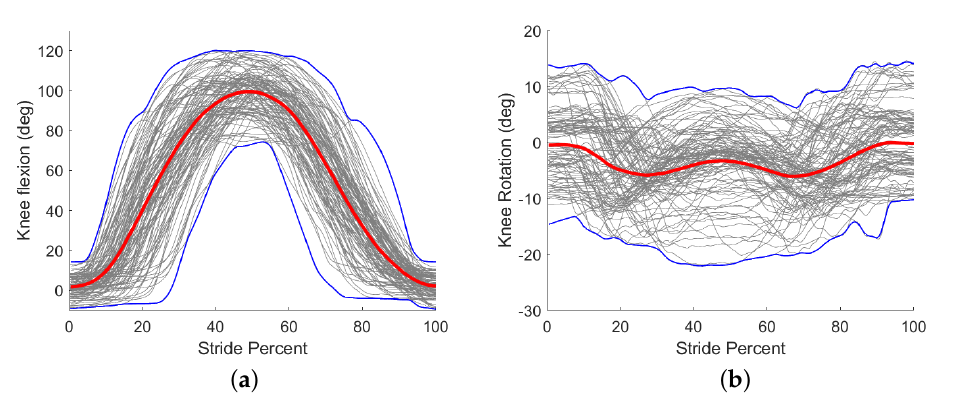
Figure 5. Knee angle ranges of all subjects of two rotational degrees of freedom. The red line represents the mean of all subjects. The blue lines represent the extrema. Positive angles correspond to knee flexion and internal rotation of the tibia. ( a ) Flexion/extension angle. ( b ) Tibia internal/ external rotation.